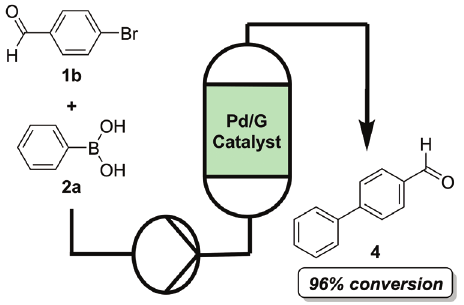
Figure 4: Process flow diagram for a continuous Suzuki-Miyaura